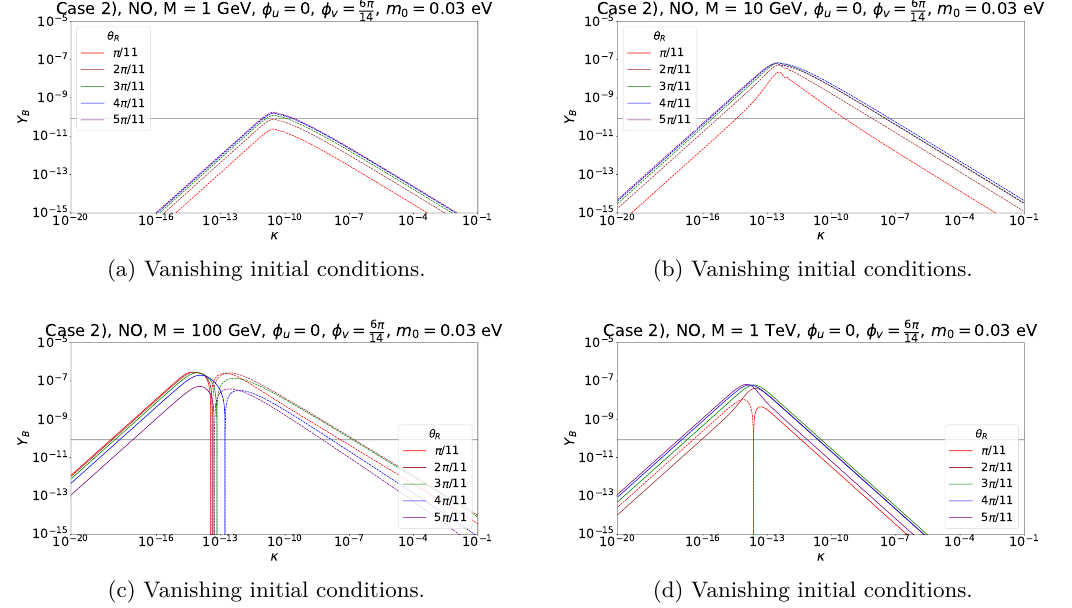
Figure 12 . Case 2) Y B as function of the splitting κ for a Majorana mass M = 1 GeV (upper left plot), M = 10 GeV (upper right plot), M = 100 GeV (lower left plot) and M = 1 TeV (lower right plot). For each of these choices, different values of θ have been studied. The parameters s and t R are fixed to s = 1 and t = 2 , respectively, corresponding to φ = 0 and φ = 6 π . Light neutrino u v 14 masses have NO with m = 0 . 03 eV. Both negative (dashed lines) as well as positive (continuous 0 lines) values of the BAU are represented. The grey line indicates the observed value of the BAU, Y B ≈ 8 . 6 · 10 − 11